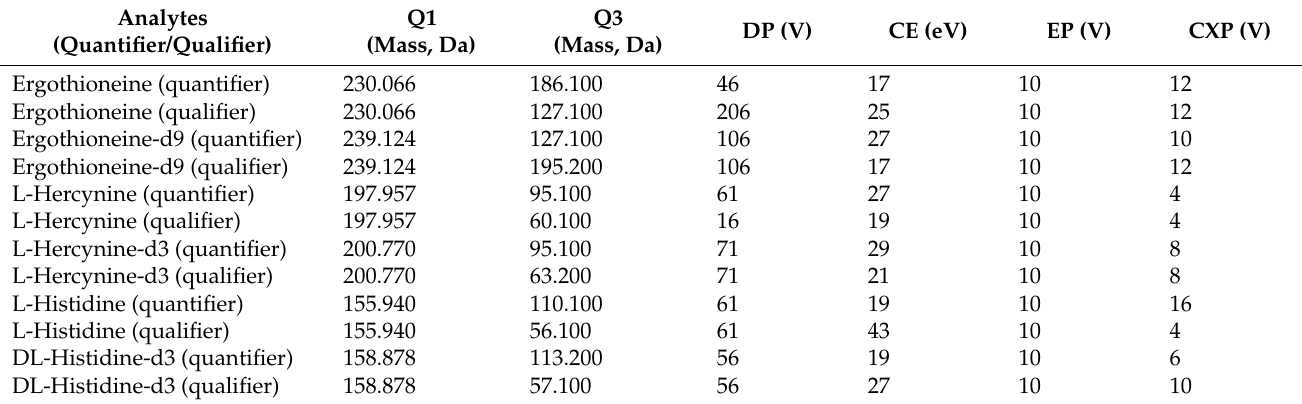
Table 2. Multiple reaction monitoring transition